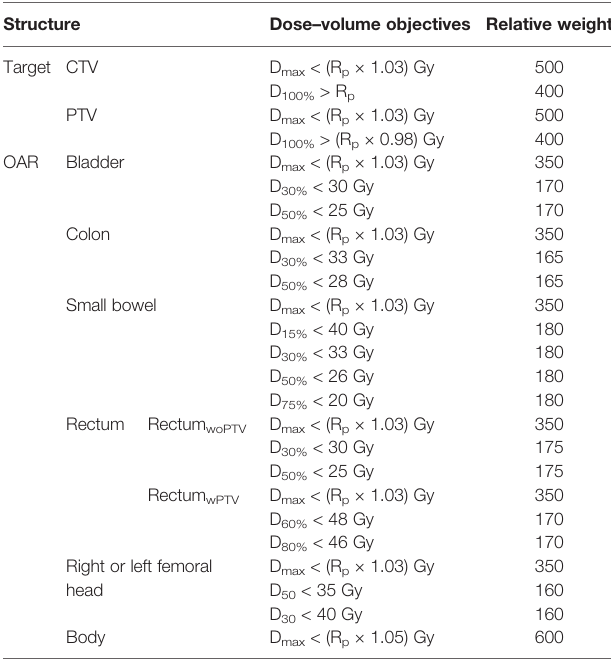
TABLE 2 | Plan optimization objectives for target and organs at risk (OAR) using dose – volume parameters and relative weights, when 95% of the planning target volume is covered by the prescribed dose (R p ) in volumetric modulated arc therapy (VMAT) plans.